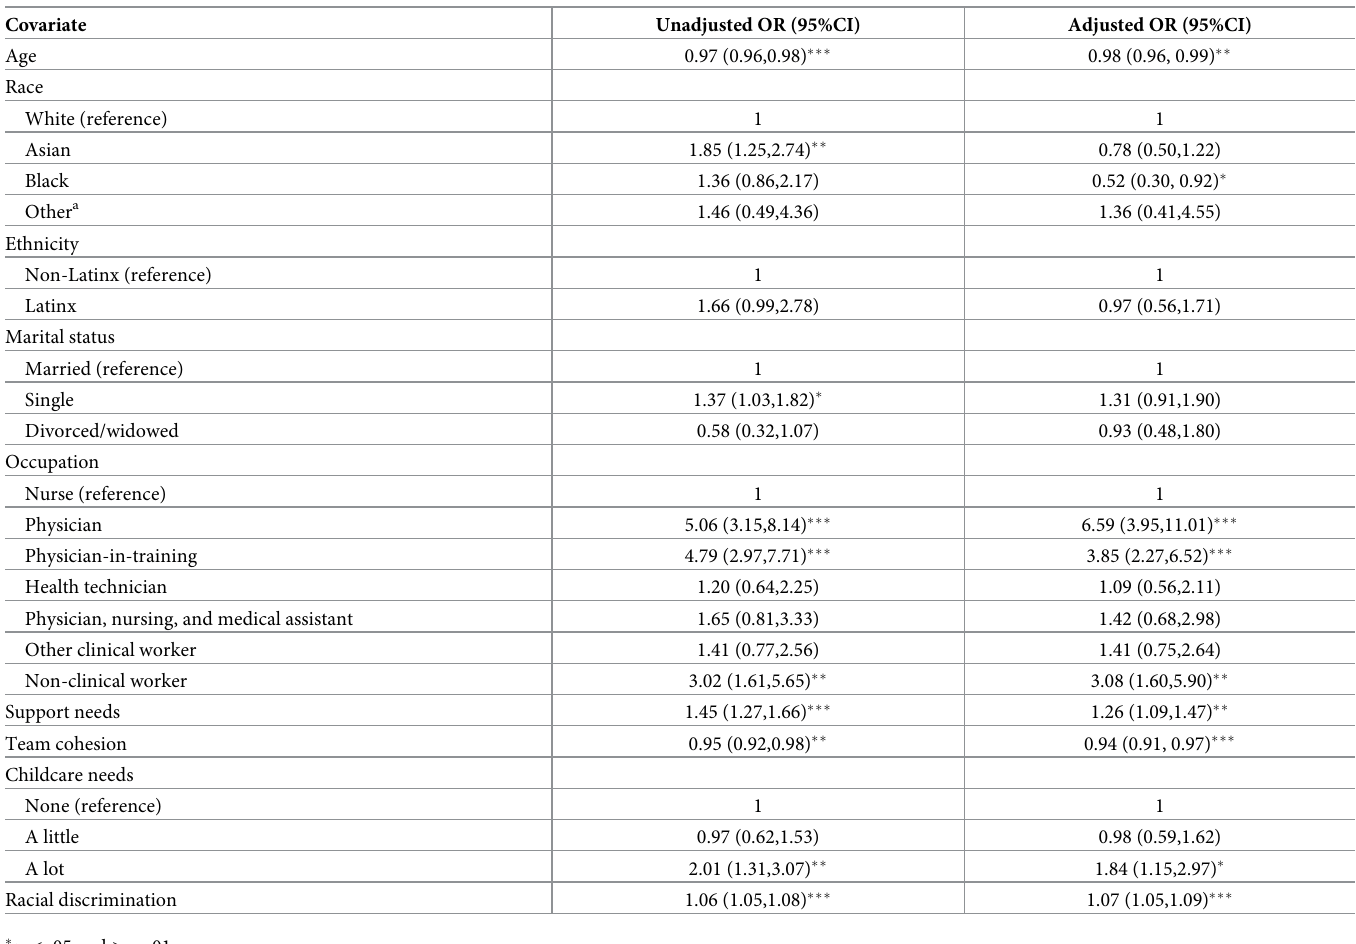
Table 2. Unadjusted and adjusted models predicting gender